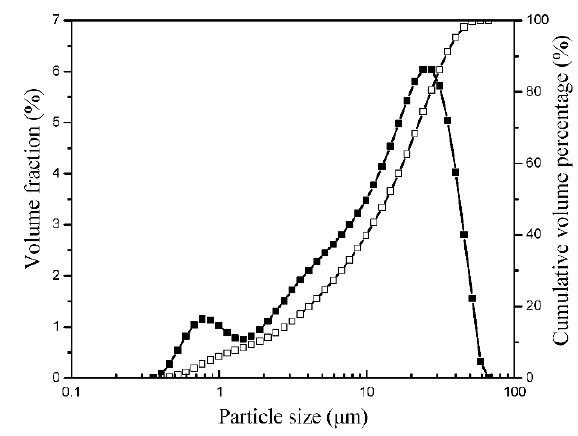
Figure 1. Particle size distribution of the cement.